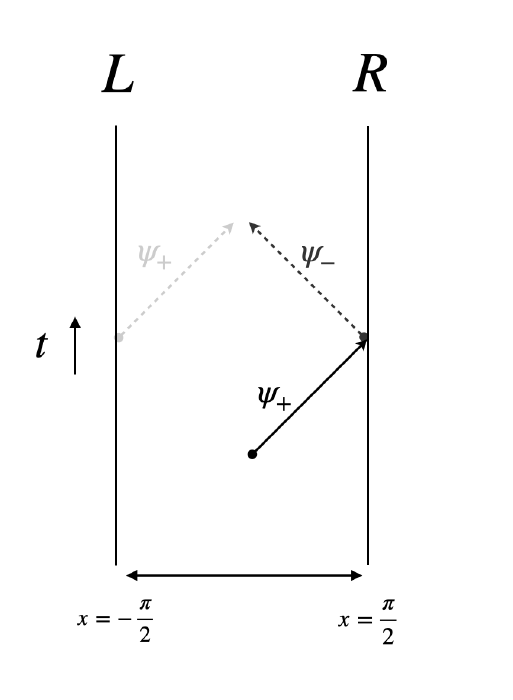
Figure 1 . A right moving massless fermion, with amplitude | ψ R the right boundary. The probability of the resulting left mover is equal to ( h 2 − 1) 2 mover emerging from the left boundary has amplitude 4 h 2